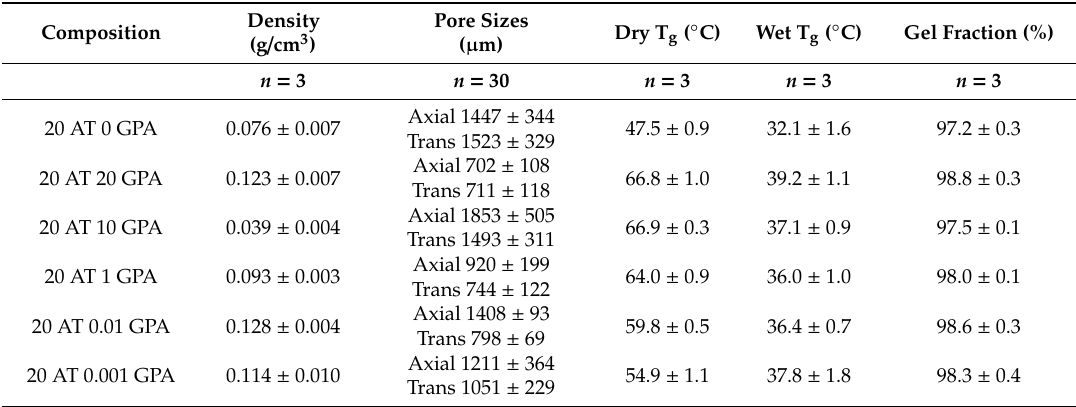
Table 2. Physical and thermomechanical properties of SMP foams. Measurements are reported as mean ± standard deviation for the indicated sample size in top